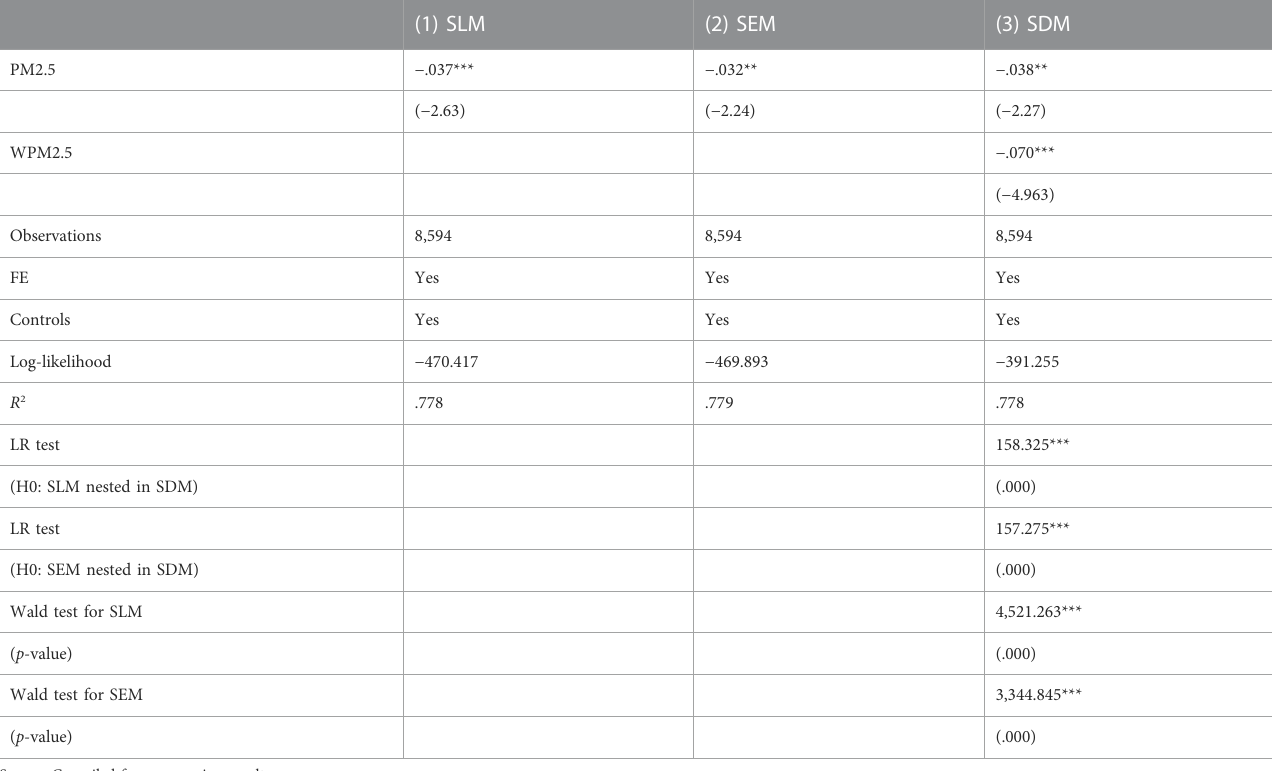
TABLE 5 Spatial Durbin Model Regression